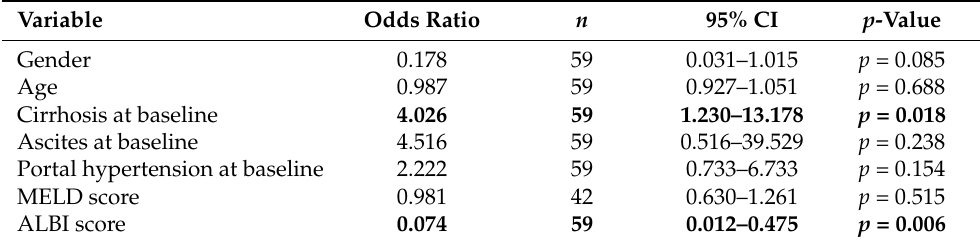
Table 3. Odds ratios for liver decompensation after SIRT (study